Question: What does this figure show? Answer in one sentence.
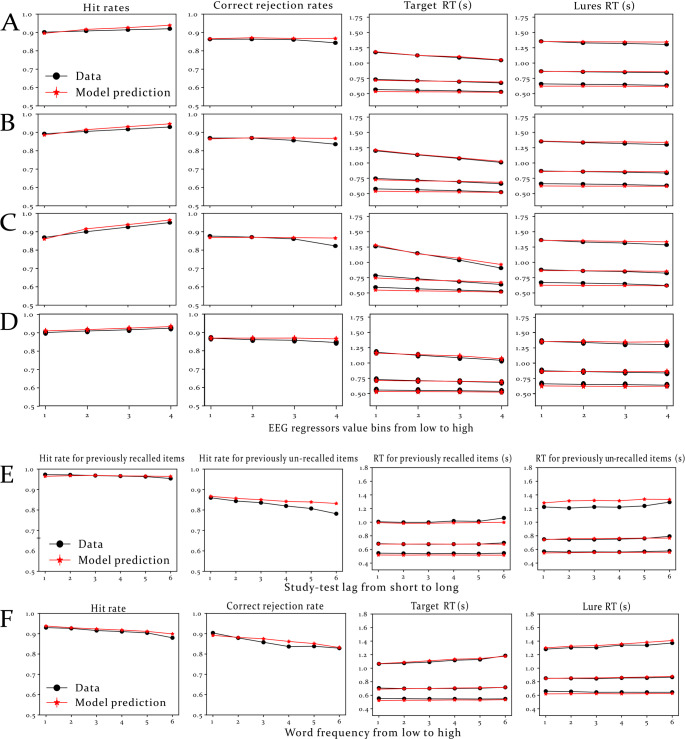
Answer: Model predictions against regressors binned by values. Model predictions of binned EEG regressors values extracted based on ( A ) 500 to 600 ms time window, ( B ) 600 to 700 ms time window, ( C ) 700 to 800 ms time window after stimulus onset for targets and lures, and ( D ) pre-stimulus EEG alpha band power for targets and lures. ( E ) Model predictions of targets varying between study-time lag and whether the item was previous recalled. ( F ) Model predictions of binned log word frequency values for targets and lures